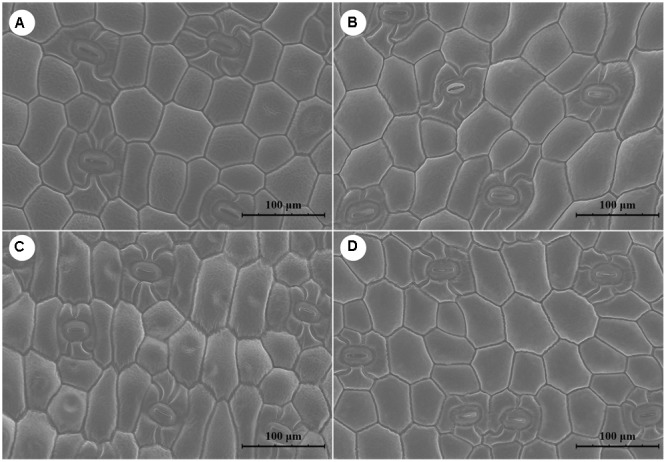
Scanning electron microscope (SEM) figure of leave surfaces of A. roxburghii plants. (A)
A. roxburghii in CLF-CK treatment; (B)
A. roxburghii in RF treatment; (C)
A. roxburghii in YF treatment; (D)
A. roxburghii in BF treatment.